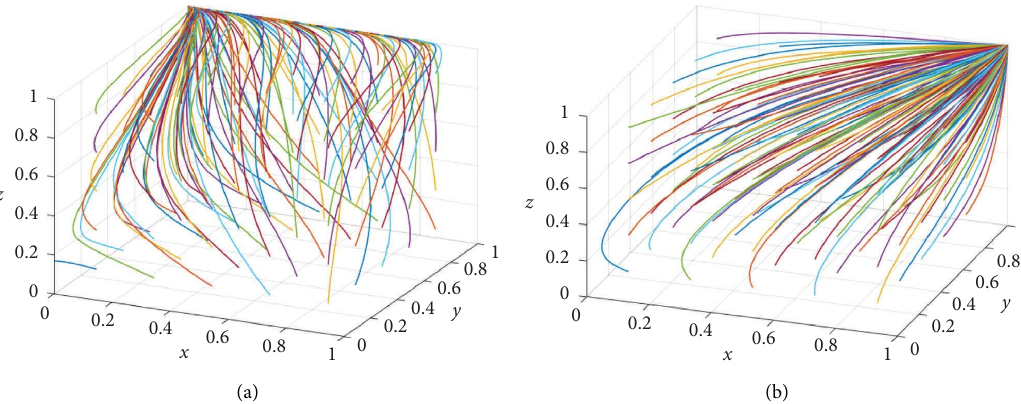
Figure 3: Evolution results with diferent initial strategy combinations: (a) equilibrium point (0, 1, 1) and (b) equilibrium point (1, 1,